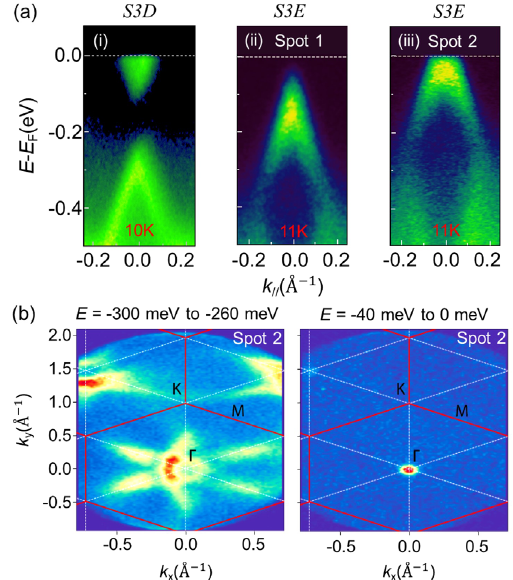
FIG. 2. Band structures of Mn ð Bi 1 − x Sb x Þ 2 Te 4 . (a) ARPES spectra measured on (i) sample S3D using the photon energy of 21.218 eVand (ii),(iii) sample S3E using the photon energy of 81 eV. Spectra in (ii) and (iii) are measured on two different spots of sample S3E . All the spectra in (a) are measured below T 25 K along the Γ − K direction [see (b)]. (b) ARPES constant energy maps at spot 2, acquired by integrating over − 300 to − 260 meV (left) and − 40 to 0 meV (right). A pointlike Fermi surface centered at Γ can be seen on the k x − k y